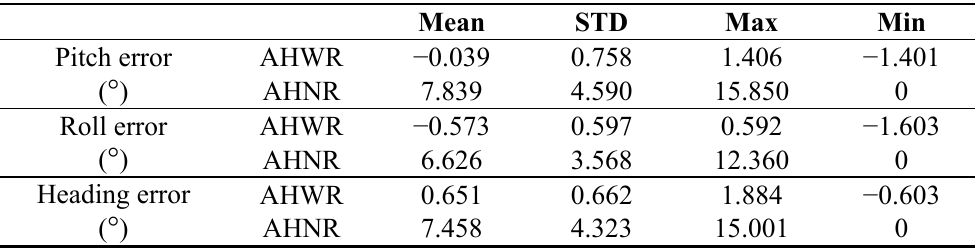
Table 1. Statistics of Figure 5.